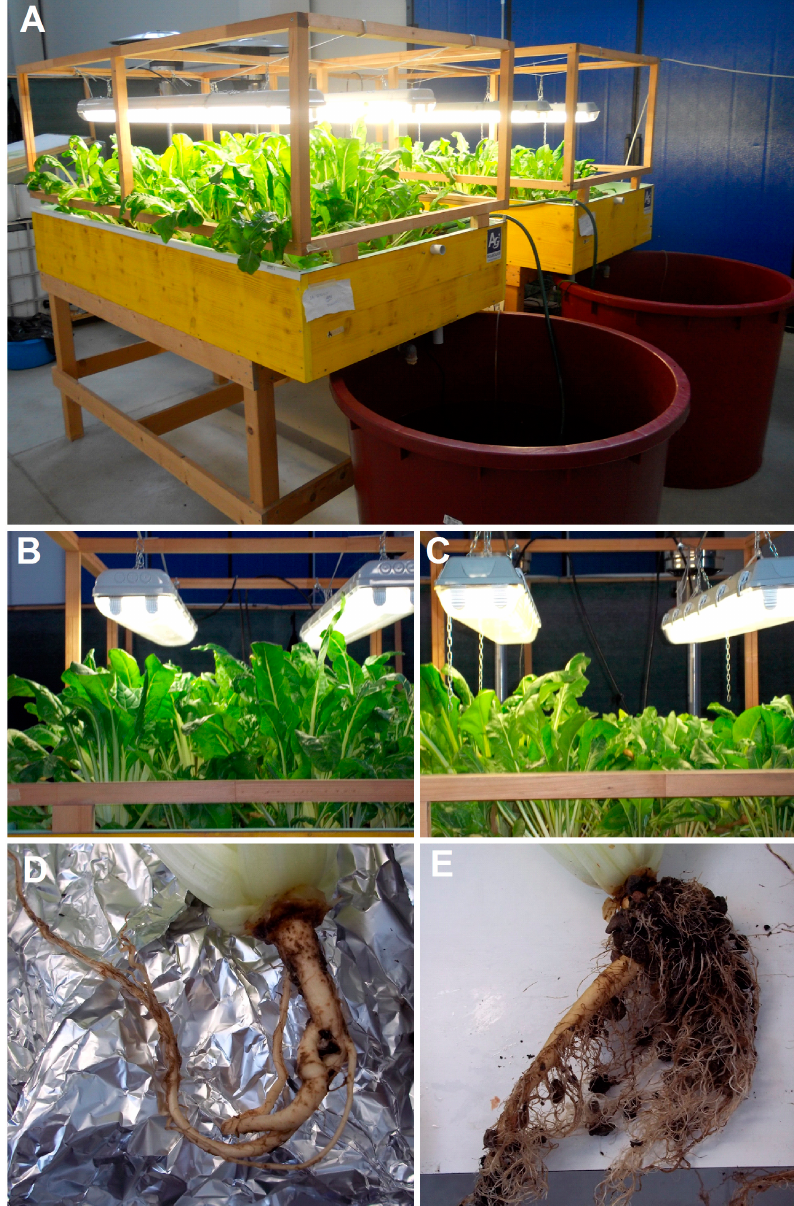
Figure 3. Different phases of sampling. ( A ) Experimental marine aquaponic systems; ( B ) Chard cultivated in AFW; ( C ) Chard cultivated in ASW; ( D ) Chard root grown in AFW; ( E ) Chard root grown in ASW.